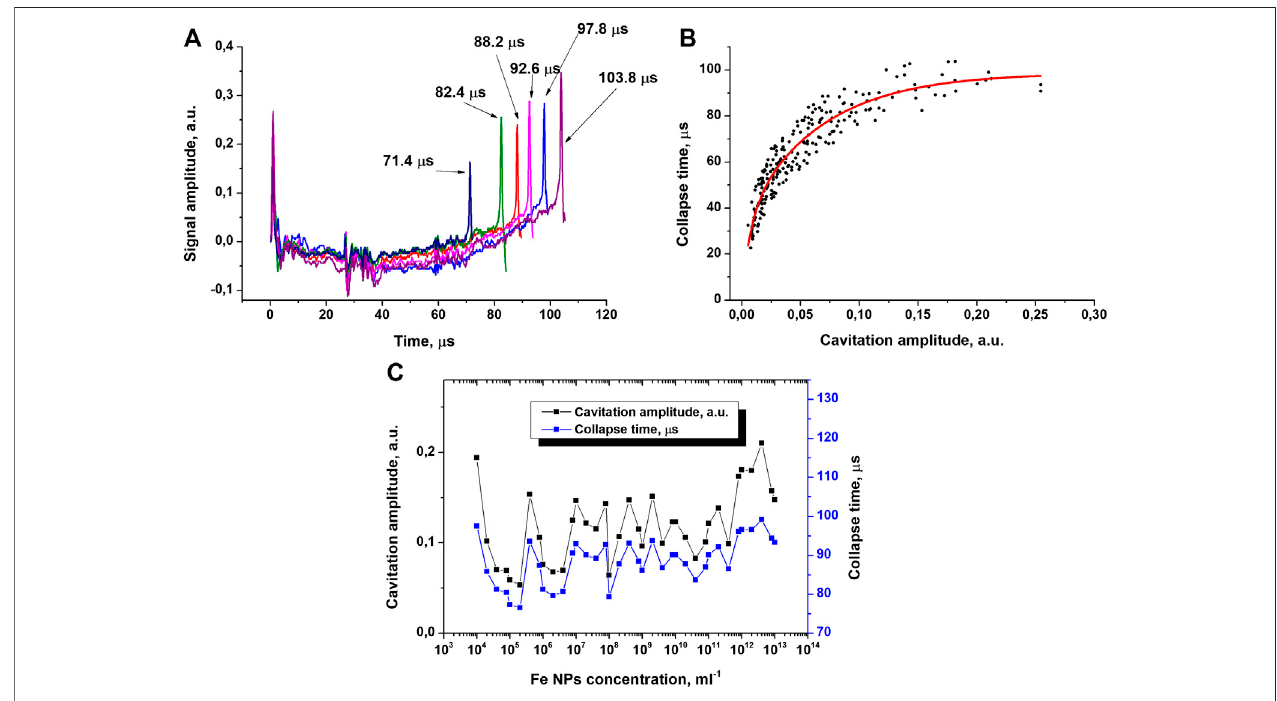
FIGURE4|(A) Acousticspectraoflaserbreakdownswithdifferentbubblelifetimes(n (cid:1) 6); (B) Dependenceofthebubblelifetimeonthesignalamplitude(n (cid:1) 9), (C) Dependence of the cavitation signal amplitude and the gas bubble lifetime on the concentration of nanoparticles (n (cid:1)